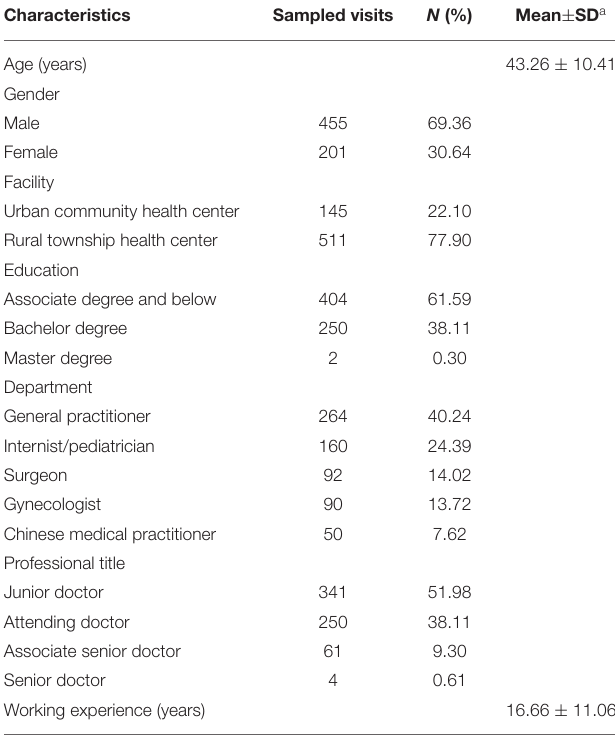
TABLE 1 | Characteristics of primary